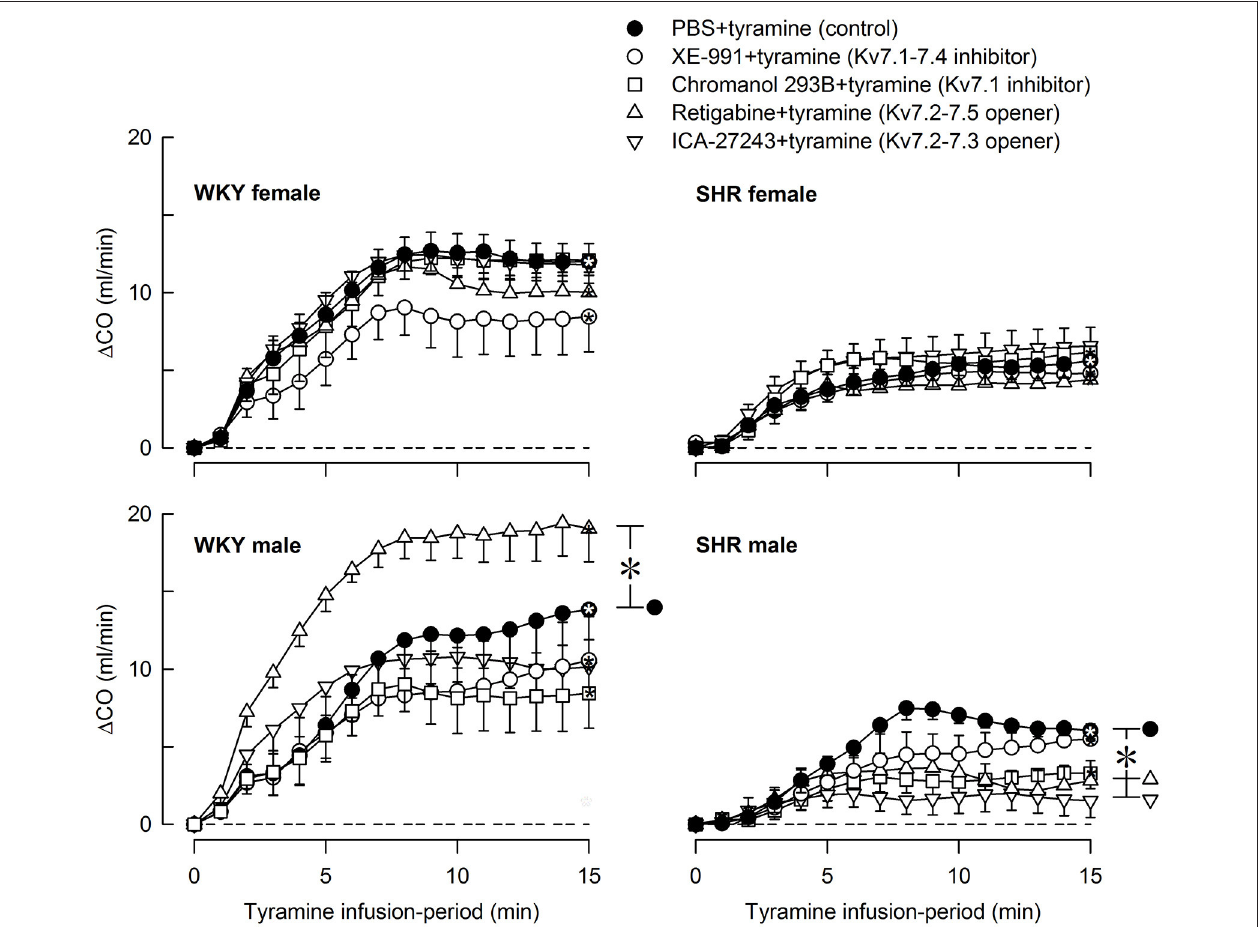
FIGURE 8 | The effect of Kv7 inhibitors/openers on the CO-response to tyramine-stimulated norepinephrine release. The rats were pre-treated as indicated by legend symbols. Analyses using Repeated Measures Analyses of Variance and Covariance indicated the presence of significant responses in all four sets of experiments, as well as the presence of group differences within the male but not female WKY and SHR. Significant differences compared to baseline were detected at 15min as indicated by the use of one-sample Student’s t -tests (*within symbol). Differences between the control and the drug-treated, experimental groups within the four sets of experiments at 15min were detected as indicated by two-sample Student’s t -tests or Kruskal–Wallis tests (* within brackets right of curves). The tyramine-induced rise in CO was clearly less in SHR than in WKY in both sexes ( P ≤ 0.002), and was slightly less in the female than in the male in SHR ( P = 0.011). A sex-dependent difference was not detected in WKY in spite of the difference in body weight. CO baselines prior to tyramine was 19 ± 1, 26 ± 2, 23 ± 1, 18 ± 1, 19 ± 1 ml/min, 15 ± 1*, 12 ± 1 ‡ , 12 ± 1, 10 ± 1 ‡ , 9 ± 1 ‡ ml/min, 29 ± 2 † , 38 ± 2 ‡ , 23 ± 2 ‡ , 26 ± 2, 23 ± 2 ml/min, and 16 ± 1*, 19 ± 2, 14 ± 2, 16 ± 1, 15 ± 1 ml/min in female WKY and SHR and male WKY and SHR, respectively ( P ≤ 0.0125 for strain- (*), sex- ( † ), or drug- ( ‡ ) related differences in the baselines). * within symbols and brackets— P ≤ 0.05 (please see the Materials and Methods section for further